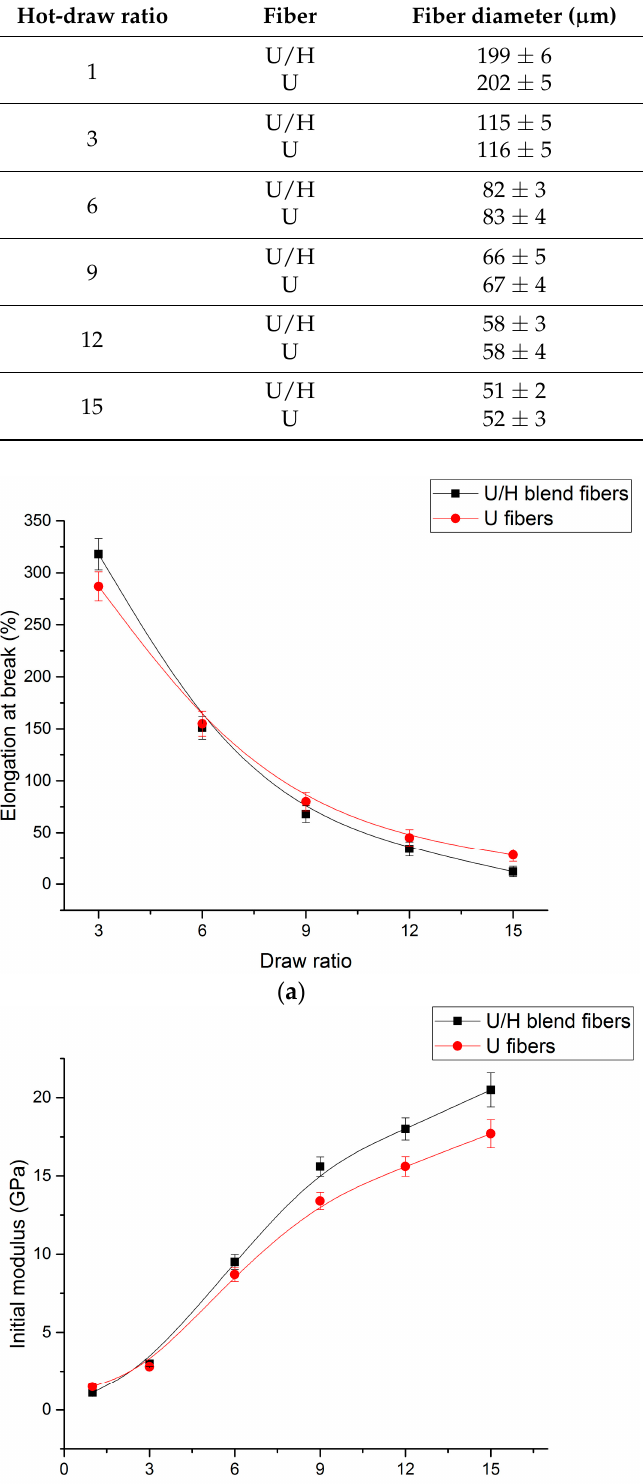
Table 3. Fiber diameters with different hot-draw ratios.